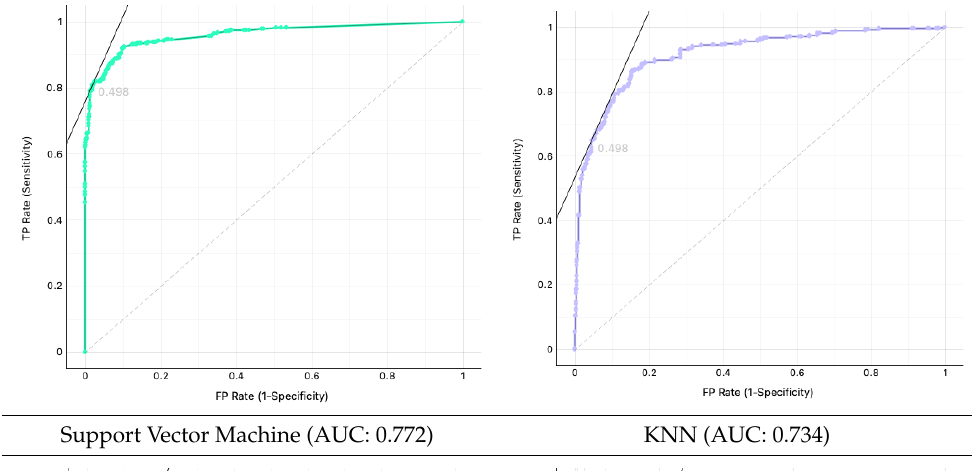
Table 4. ROC Curve.